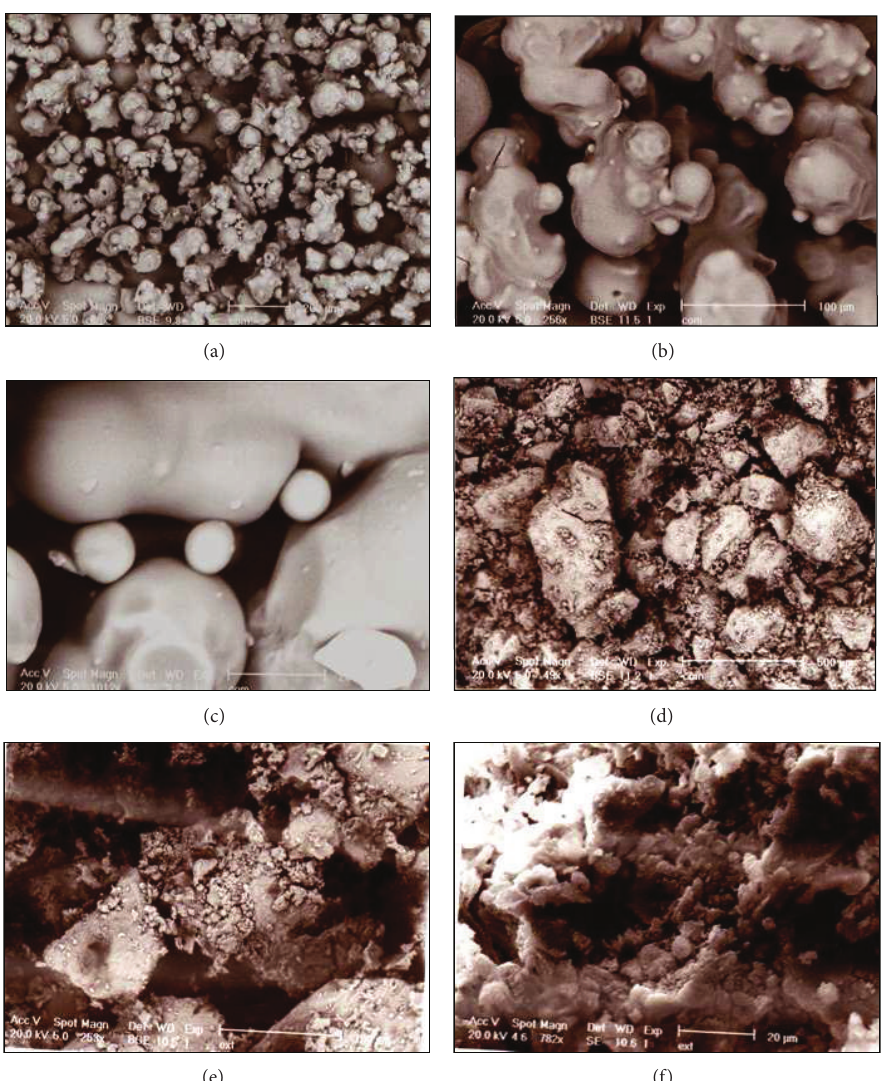
Figure 6: Scanning electron microscopy images of commercial inulin (a, b, and c) and soluble fibres concentrate of Agave Americana L. (d, e, and f); scale bar for (d), 500 𝜇 m; scale bar for (a) and (e), 200 𝜇 m; scale bar for (b), 100 𝜇 m; scale bar for (c) and (f), 20 𝜇